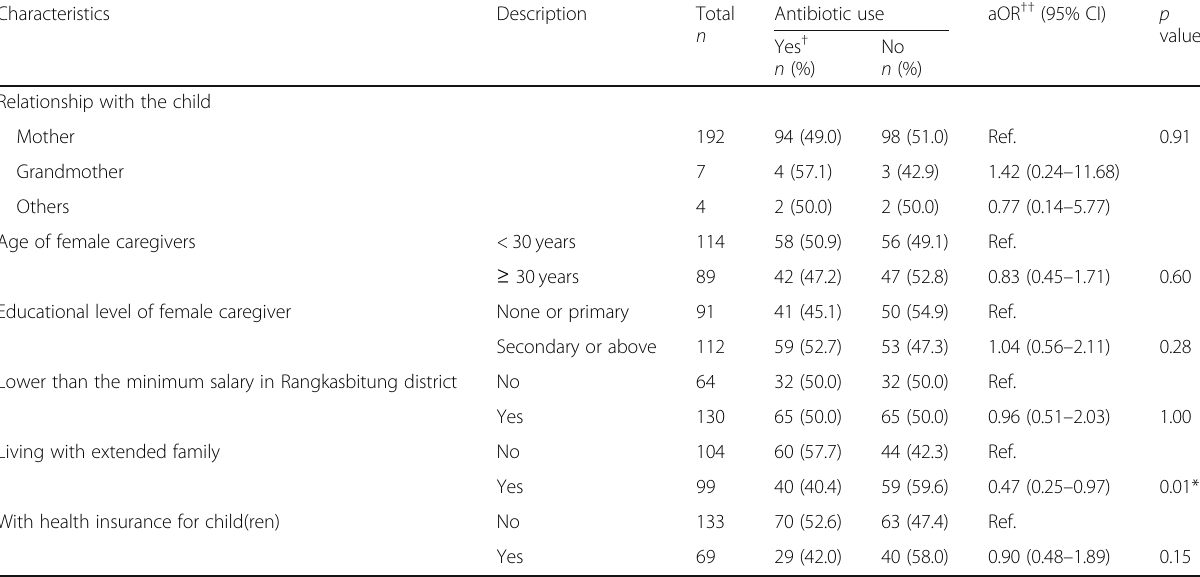
Table 4 Association between antibiotic use and characteristics of female caregivers ( n = 203)